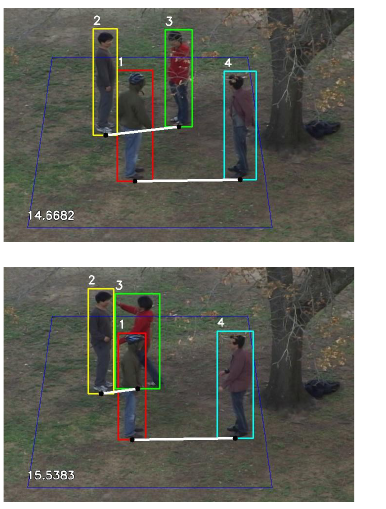
Figure 7. Distance estimation